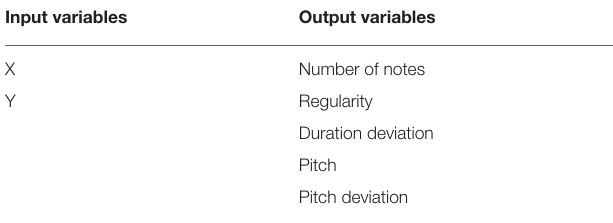
TABLE 1 | Input and output variables for algorithmic composition